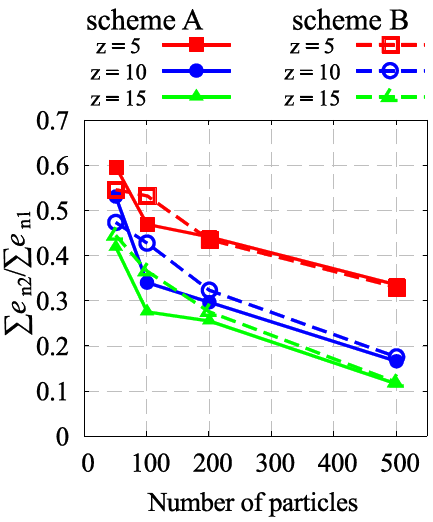
Figure 24. Kinetic energy of rebounding particles, where the energy is e n = 0.5 ρp ( w p2 ).